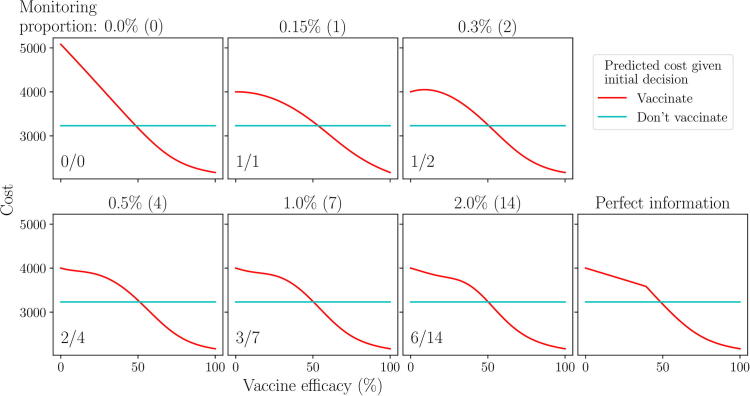
Scenario 1: effect of monitoring proportion on the predicted outbreak cost given an initial decision to vaccinate or not. Predicted outbreak cost over vaccine efficacy, given an initial decision to vaccinate (red) or not (blue), for different monitoring proportions (ρ; Table A.2). The number of monitored vaccinations is given in brackets beside the proportion. The required number of successful vaccinations from the total number monitored in order to make a decision to vaccinate is shown in the lower left corner of each panel. The far right panel assumes perfect information is obtained after day t∗, that is, we will know the true vaccine efficacy exactly when making the final decision. Epidemiological and vaccination parameters are set to those in Table A.2: Scenario 1.